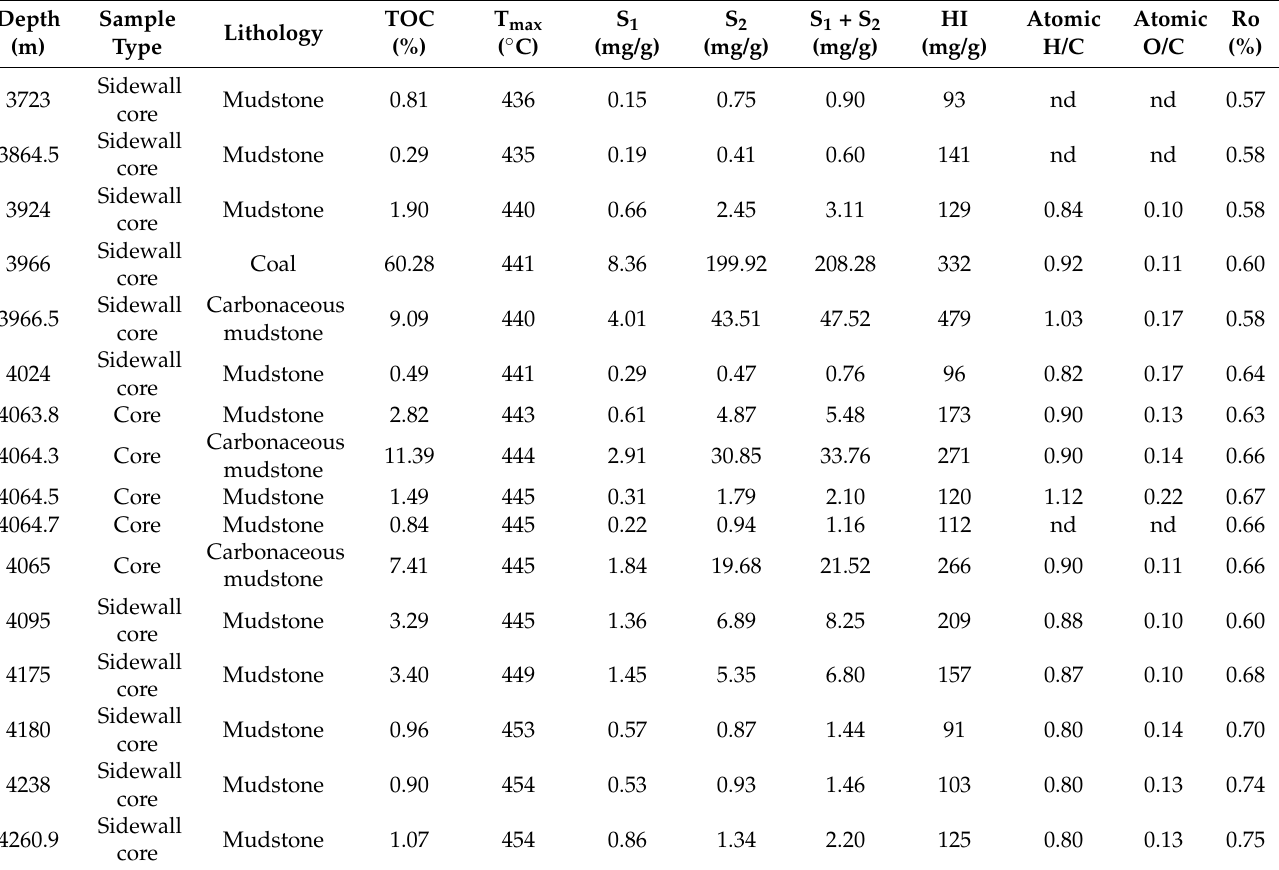
Table 1. Origin and bulk properties of the Eocene Pinghu Formation source rock samples from well W-3, Xihu Sag.